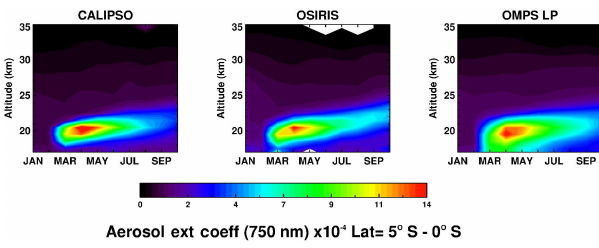
Figure 25. Monthly zonal mean aerosol extinction profiles at 750nm derived from CALIPSO, OSIRIS, and OMPS LP measure- ments during the aftermath of the Kelut eruption in